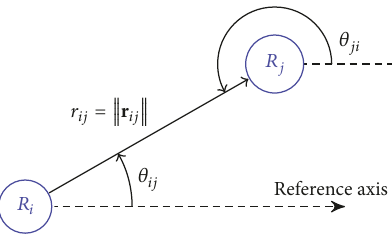
where 𝑄 = 𝑁 is the set of vertices related to the agents; 𝐸 = {(𝑗, 𝑖) ∈ 𝑄 × 𝑄} is the set of edges that represent the possible interagent communications; therefore (𝑗, 𝑖) ∈ 𝐸 if 𝑗 ∈ 𝑁 𝑖